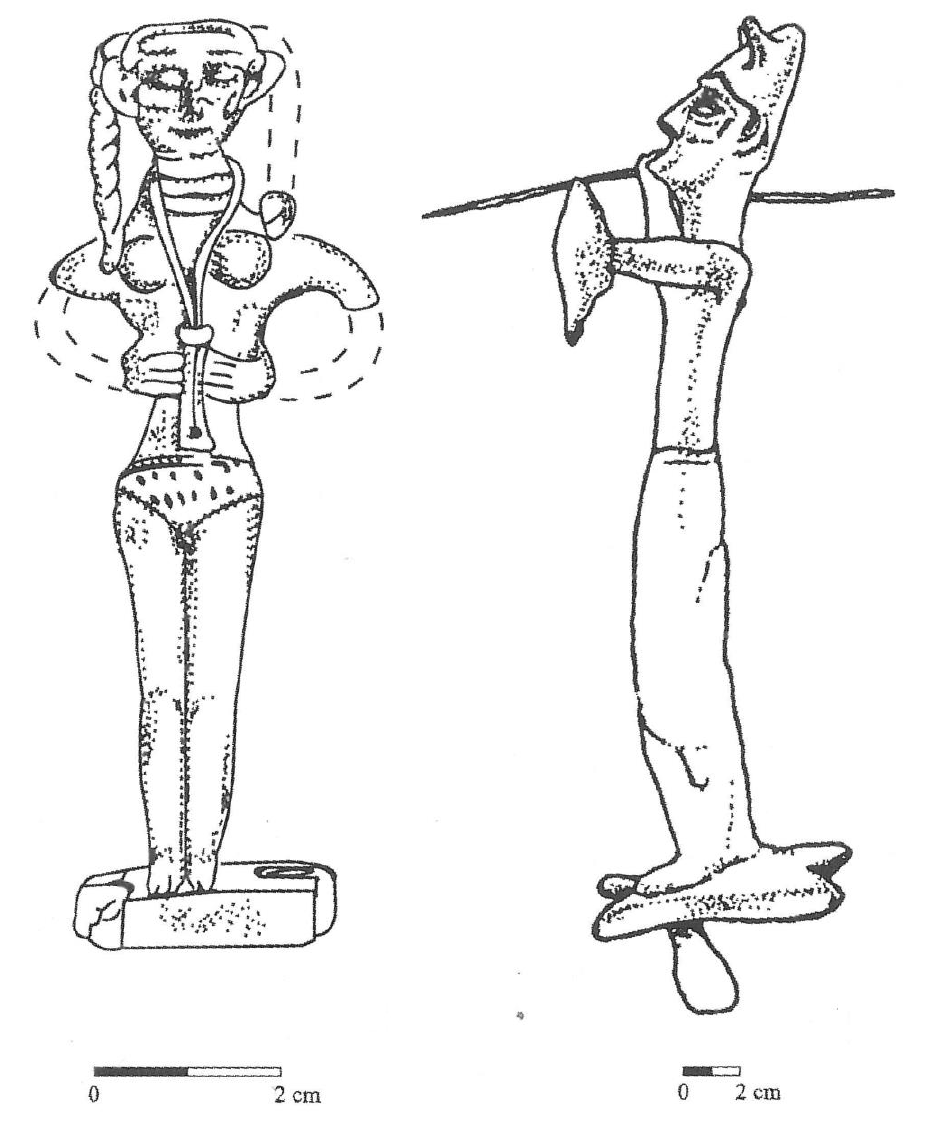
Figure 1. The so-called ‘Bomford Goddess’ ( left ) and the ‘Ingot God’ of Enkomi ( right ) (after Webb 2001, p. 75, Figure